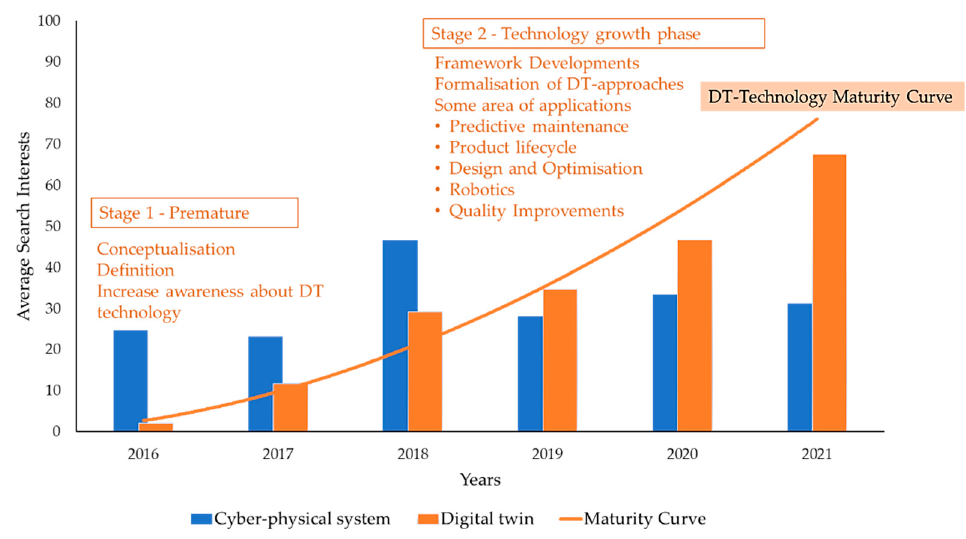
Figure 1. Search interest and technology maturity curve of CPS and DT, since 2016. The graph illustrates the search interest for digital twin (DT) and cyber–physical systems (CPS) in Google search engine from Jane 2016–September 2021. The trend suggests that the focus towards DT is growing. Data source: Google Trends.